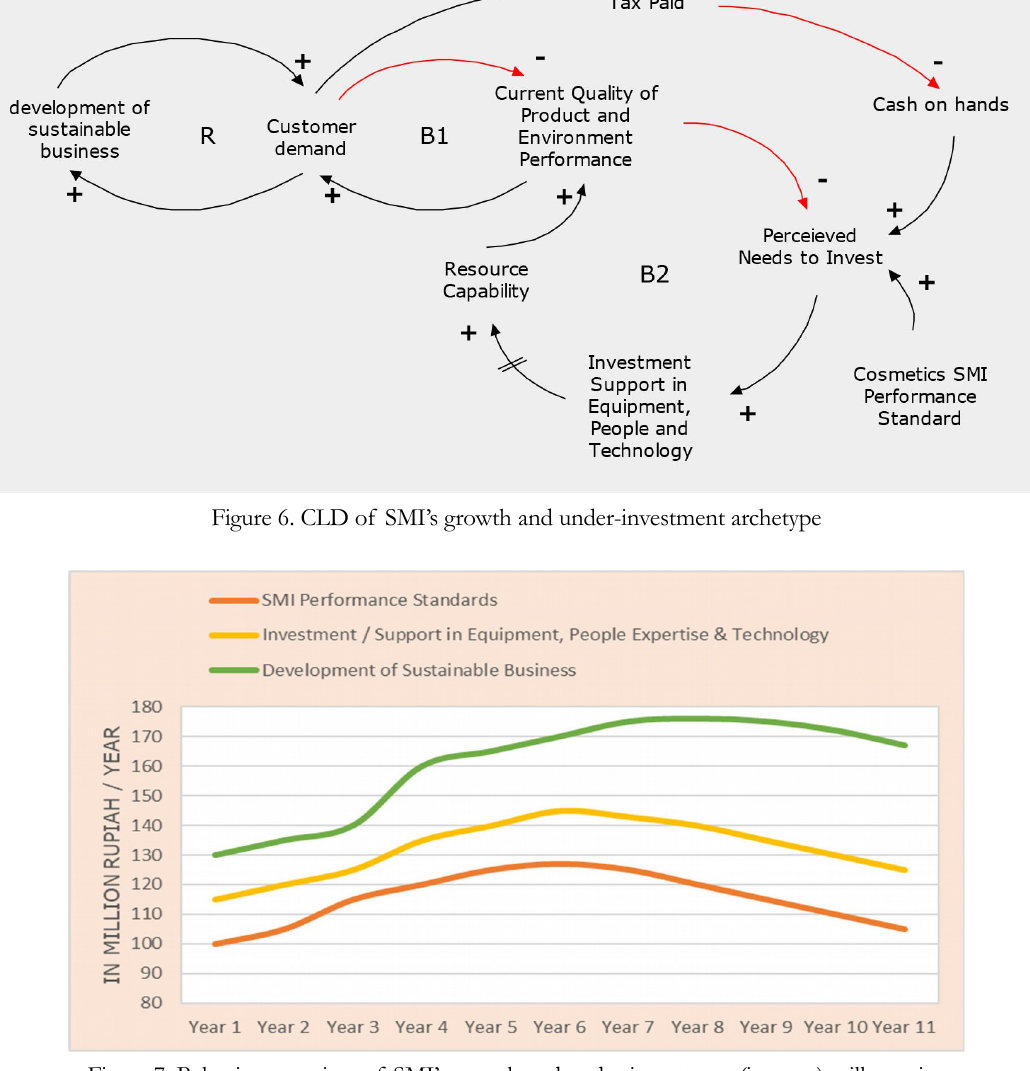
Figure 7. Behavior over time of SMI’s growth and under-investment (in